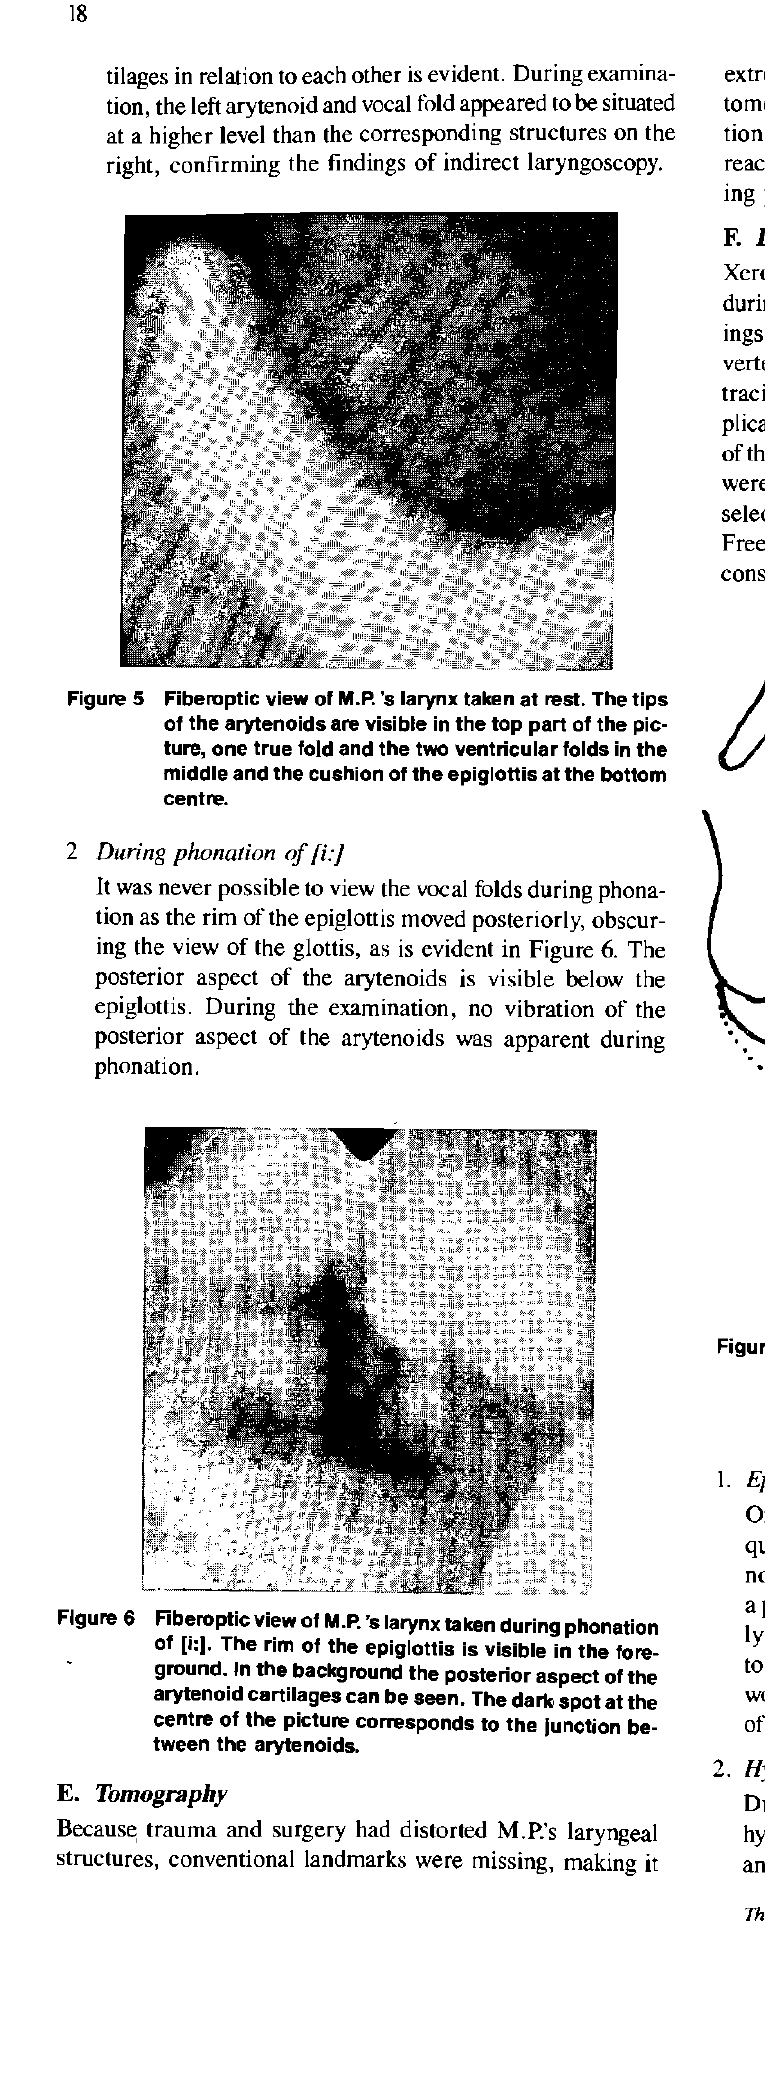
Figure 6 Fiberoptic view of M.P. 's larynx taken during phonation of [I:]. The rim of the epiglottis is visible in the fore- ground. In the background the posterior aspect of the arytenoid cartilages can be seen. The dark spot at the centre of the picture corresponds to the junction be- tween the